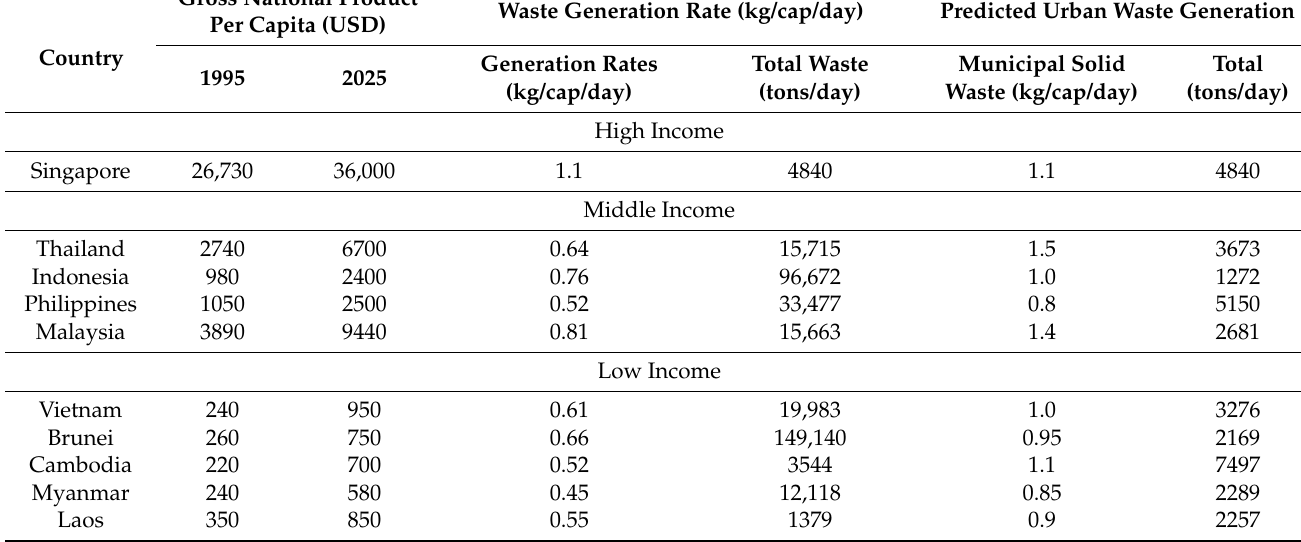
Table 1. The rate of municipal solid waste generation per capita in urban ASEAN by 2025. Reprinted/adapted with permission from [5]. 2009.